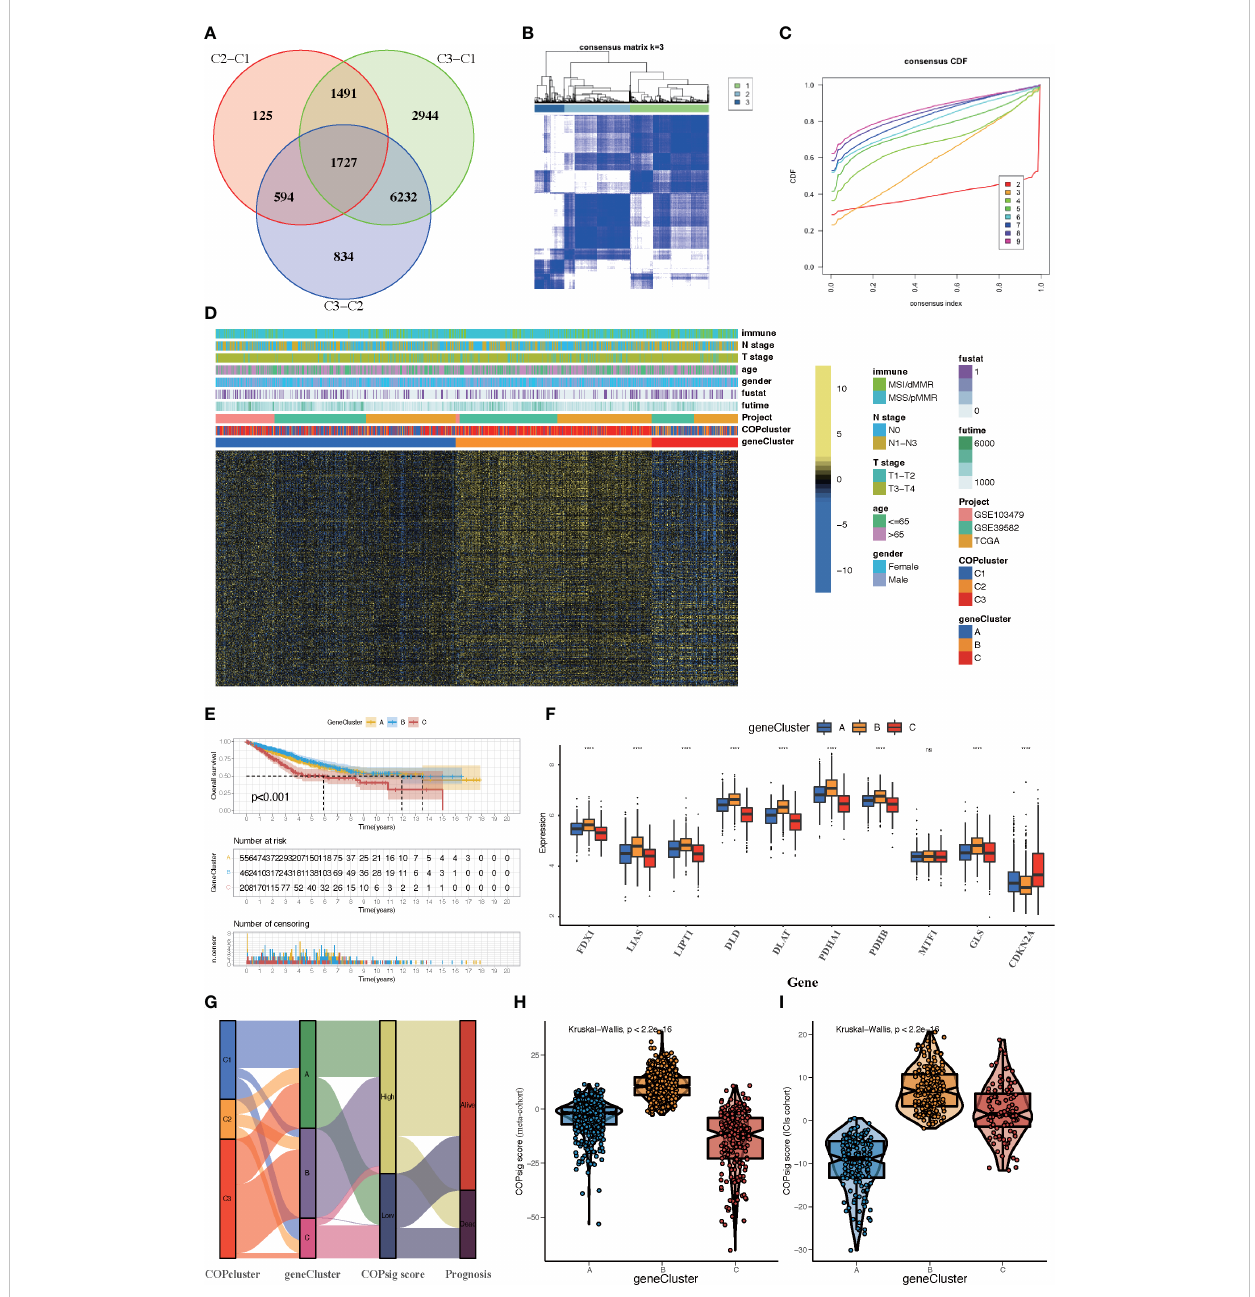
FIGURE 4 Construction of COP gene clusters and COPsig score. (A) A total of 1,727 cuprotosis-related differentially expressed genes (DEGs) between three cuprotosis patterns were illustrated in the Venn diagram. (B) Unsupervised consensus clustering for 375 prognosis-related DEGs in the meta-cohort and the consensus matrices for k = 3. (C) Consensus values range from 0 to 1. (D) Expression heatmap of three COP gene clusters of 375 DEGs. Immune subtype, COPcluster, age, gender, N stage, T stage, and prognosis were annotated. Yellow represents a high expression of DEGs, and blue represents a low expression. (E) Kaplan – Meier curves for the three COP gene clusters, including 556 samples in gene cluster A, 462 samples in gene cluster B, and 208 samples in gene cluster C (log-rank test). Gene cluster A showed a signi fi cantly better prognosis than the other two gene clusters. (F) The expression level of 10 CRGs in three gene clusters. The line in the box represents the median value. The bottom and top of the boxes are the 25th and 75th percentiles (interquartile range). The whiskers encompass 1.5 times the interquartile range. The asterisks illustrate the statistical p - value (* p < 0.05, ** p < 0.01, *** p < 0.001, **** p < 0.0001, ns p > 0.05). (G) Alluvial diagram showing the changes in COPclusters, gene clusters, COPsig score, and patients ’ prognosis. (H, I) Differences in COPsig score among three COP gene clusters in the meta-cohort (H) and the ICI cohort (I) . The Kruskal – Wallis test was used to compare the statistical difference between three gene clusters ( p <